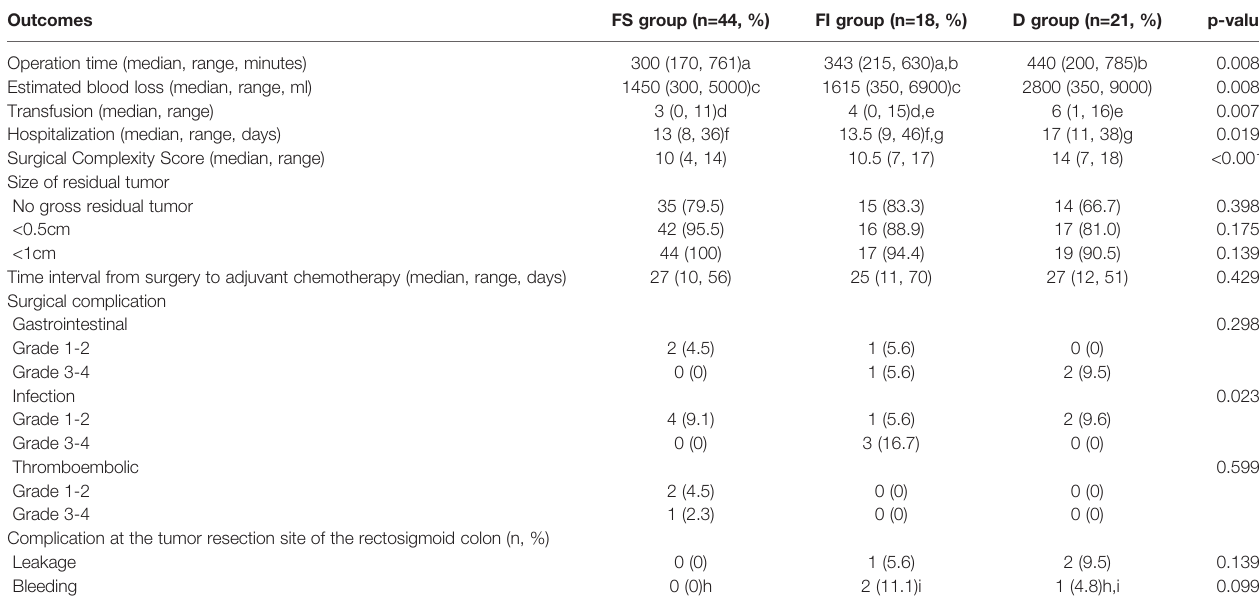
TABLE 3 | Operative outcomes. Outcomes